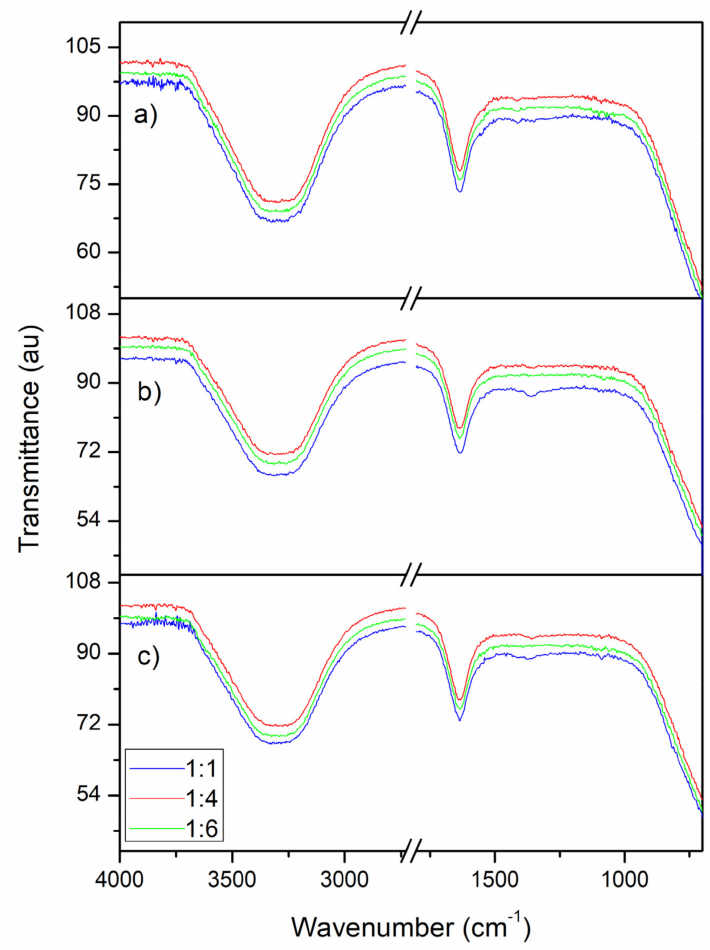
Figure 9. FT-IR spectra for liquid–phase products: ( a ) 673.15 K; ( b ) 713.15 K; ( c ) 773.15 K. Two intense peaks were observed in the range of 3000–3600 cm − 1 and at 1621 cm − 1 . The first peak was associated to alcohol and carboxylic acid groups, and the second ex- hibited carboxylic acids, amides and heterocyclic compounds. Those analyses confirmed the presence of phenolic compounds and polycyclic aromatic hydrocarbons since refrac- tory compounds could not be degraded at these the temperature conditions. Phenolic compounds were the most difficult chemicals to be decomposed and hence inhibited gas formation under supercritical water conditions. Besides, the high concentration of biomass on feed for 1:1 B:W mass ratio was not beneficial for a better gas yield during steam reforming or water-gas shift reactions since these reactions needed sufficient